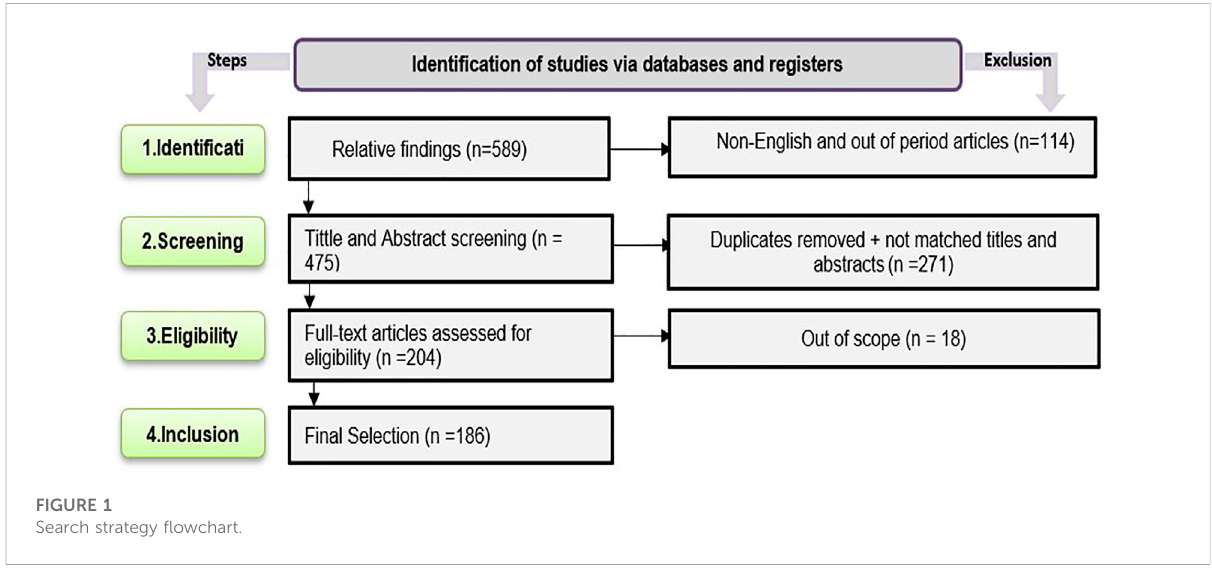
FIGURE 1 Search strategy fl owchart.